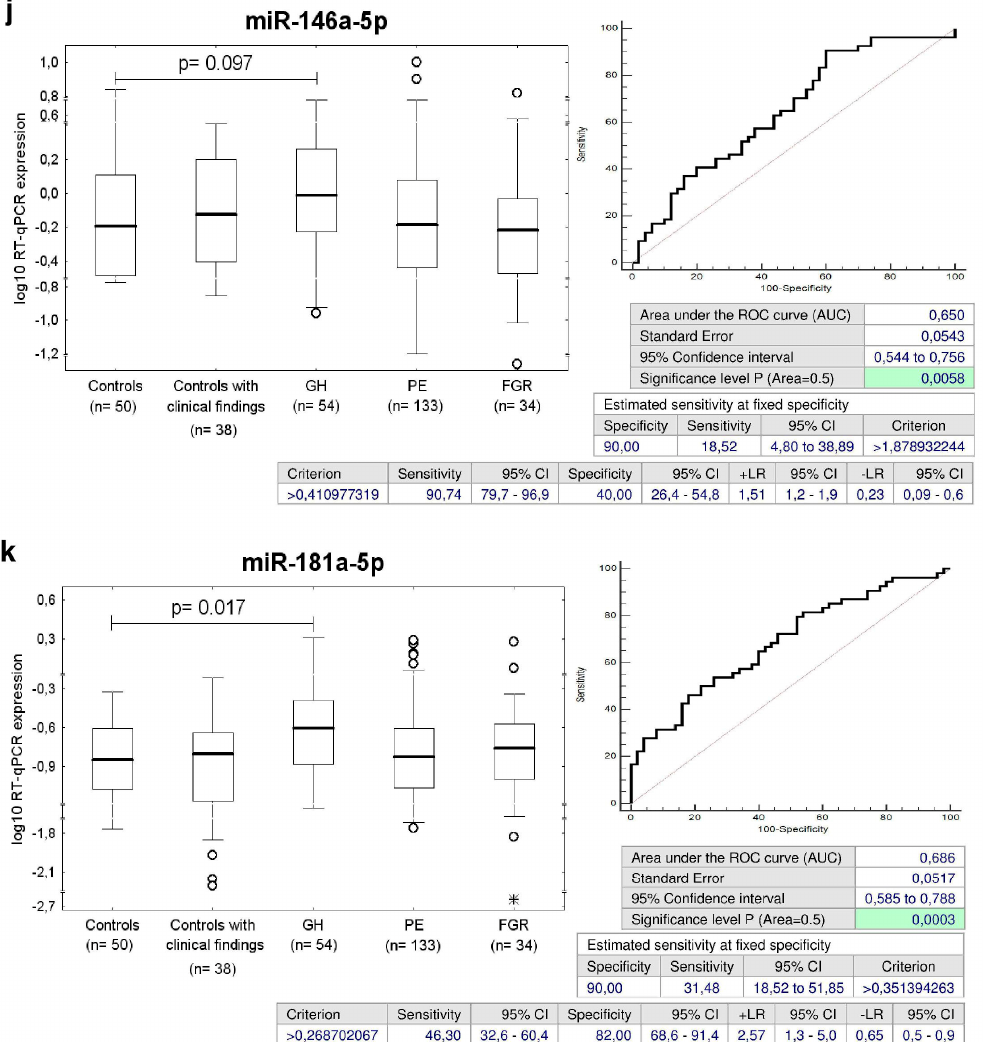
Figure 2. Postnatal microRNA expression profile in children descending from GH pregnancies. ( a – k ) Up-regulation of miR-1-3p, miR-17-5p, miR-20a-5p, miR-21-5p, miR-23a-3p, miR-26a-5p, miR-29a-3p, miR-126-3p, miR-133a-3p, miR-146a-5p, and miR-181a-5p was observed in children descending from GH pregnancies when the comparison to the controls was performed.